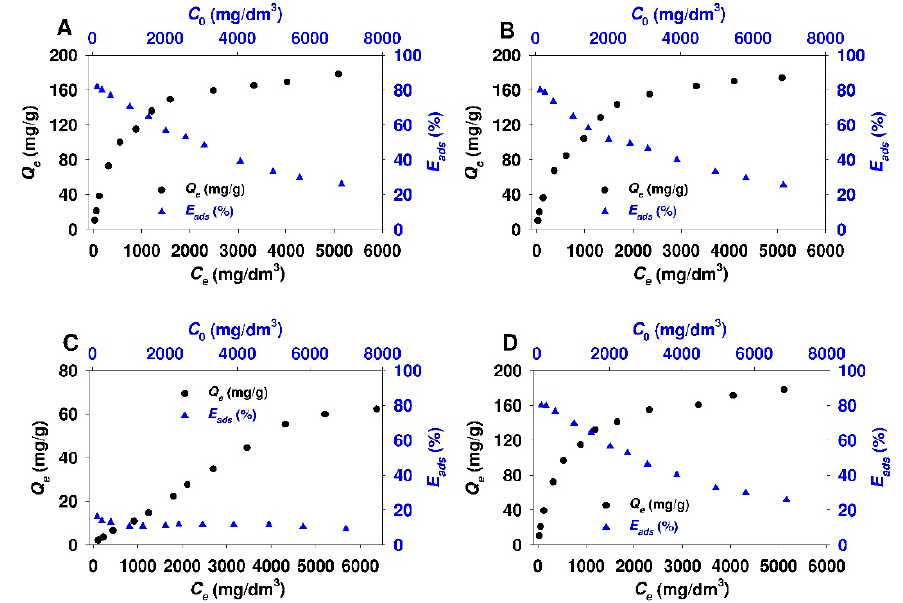
Figure 6. Adsorption isotherms and adsorption efficiency of 18 β -glycyrrhetinic acid onto: ( A ) SBA-15-AP, ( B ) SBA-15-MAP, ( C ) SBA-15-DMAP, and ( D ) SBA-15-AEAP mesoporous sorbents.